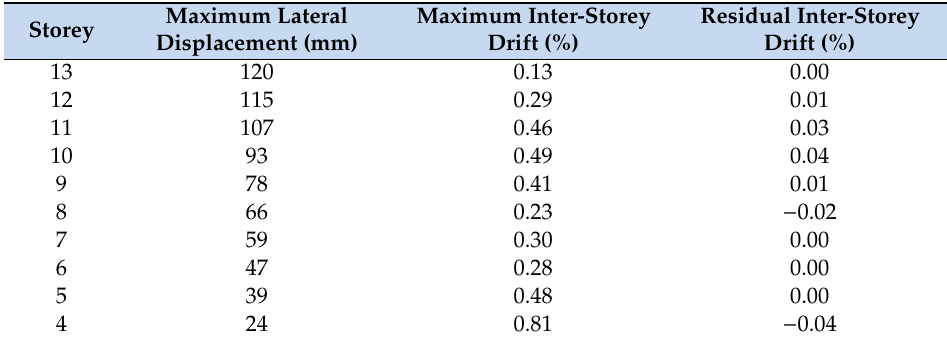
Table 12. Results from reduced rotation base sti ff ness for the whole building with slab model including THC for the ULS